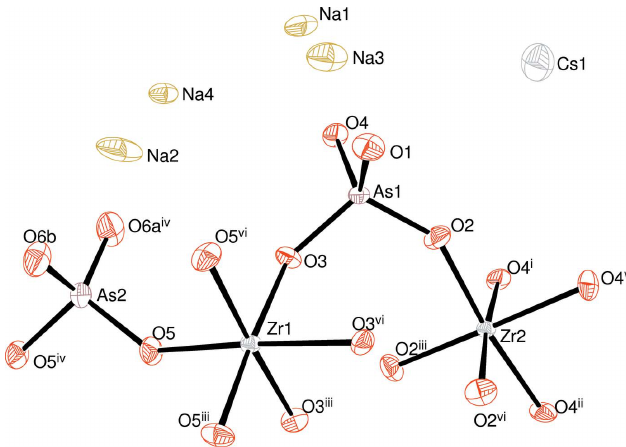
Figure 1 The asymmetric unit of (I) expanded to include the full Zr and As coordination polyhedra showing 50% displacement ellipsoids. Only one disorder component about As2 is shown. Symmetry codes: (i) 1 (cid:2) x , 1 (cid:2) y , (cid:2) z ; (ii) y , 1 (cid:2) x (cid:2) y , (cid:2) z ; (iii) 1 (cid:2) y , 1 + x (cid:2) y , z ; (iv) 4 (v) x (cid:2) y, x , (cid:2) z; (vi) y (cid:2) x, 1 (cid:2) x , z .